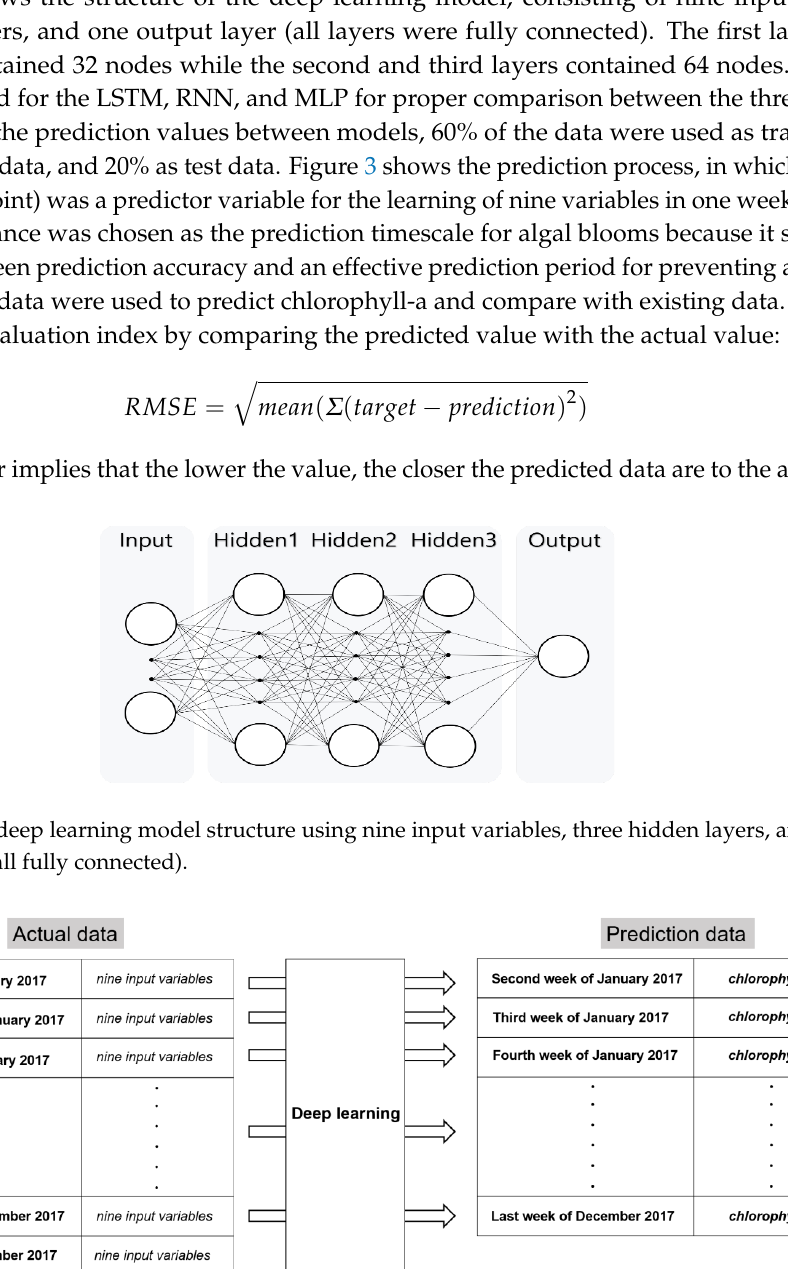
Figure 3. The deep learning prediction process using temporal data.